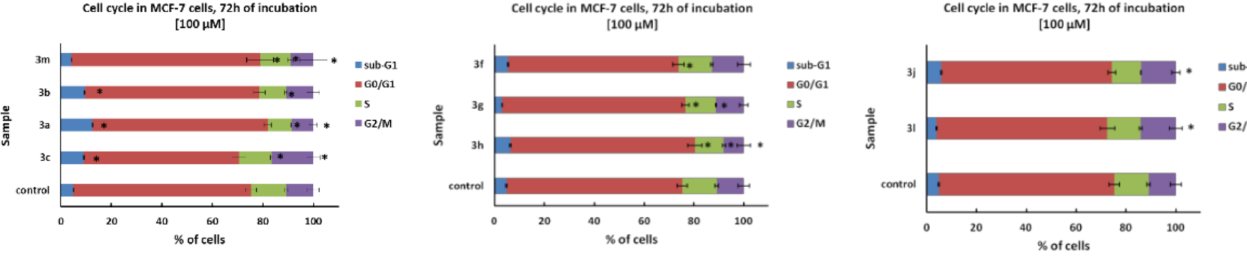
Figure 5. Cell cycle in MCF-7 cells after a 72h incubation with compounds with the concentration of 100 µ M. The results were presented as mean value ± SD. The statistical analysis was based on a t-test, and a p -value less than 0.05 was considered statistically significant in comparison to the untreated controls (indicated with a